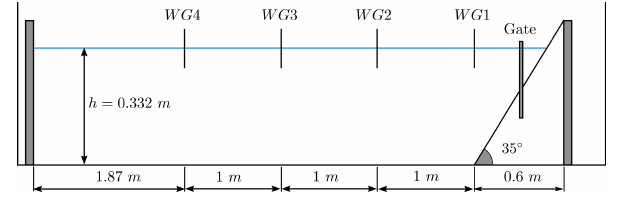
Figure 2. BP4 sketch showing the longitudinal cross section of the IRPHE’s precision tank. The figure shows the location of the plane slope, the sluice gate, and the four gages (WG1–WG4).